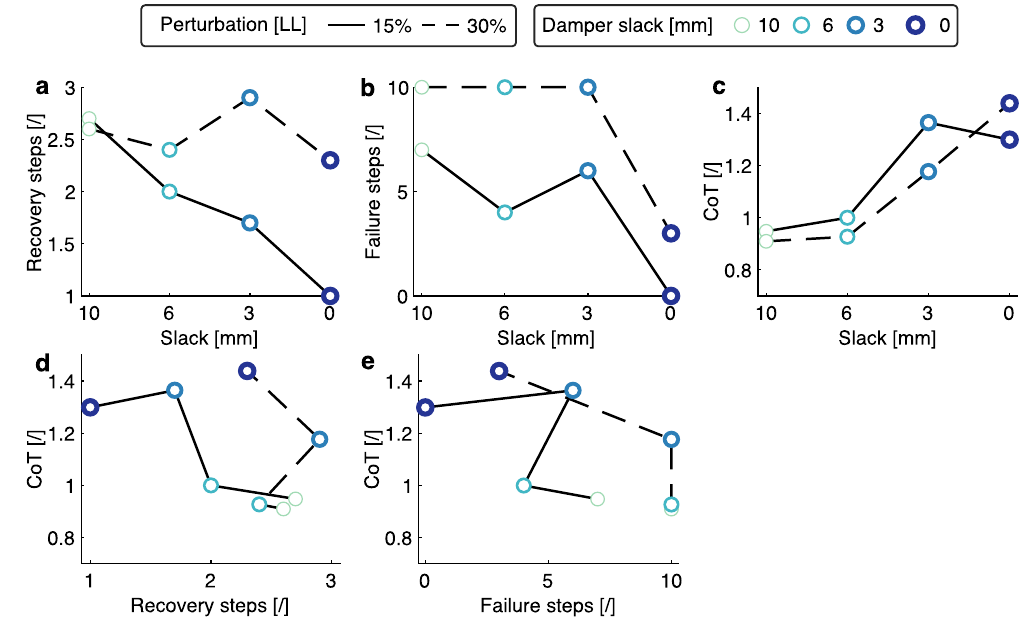
Figure 4. Forward hopping with ramp-up and step-down perturbation: The robustness of the robot system is quantified with the number of steps needed to recover stable hopping ( a ) and the number of failed trials in 10 attempts ( b ). ( c ) The relationship between the CoT and the damper slack settings. ( d , e ) show the trade-off between robustness and